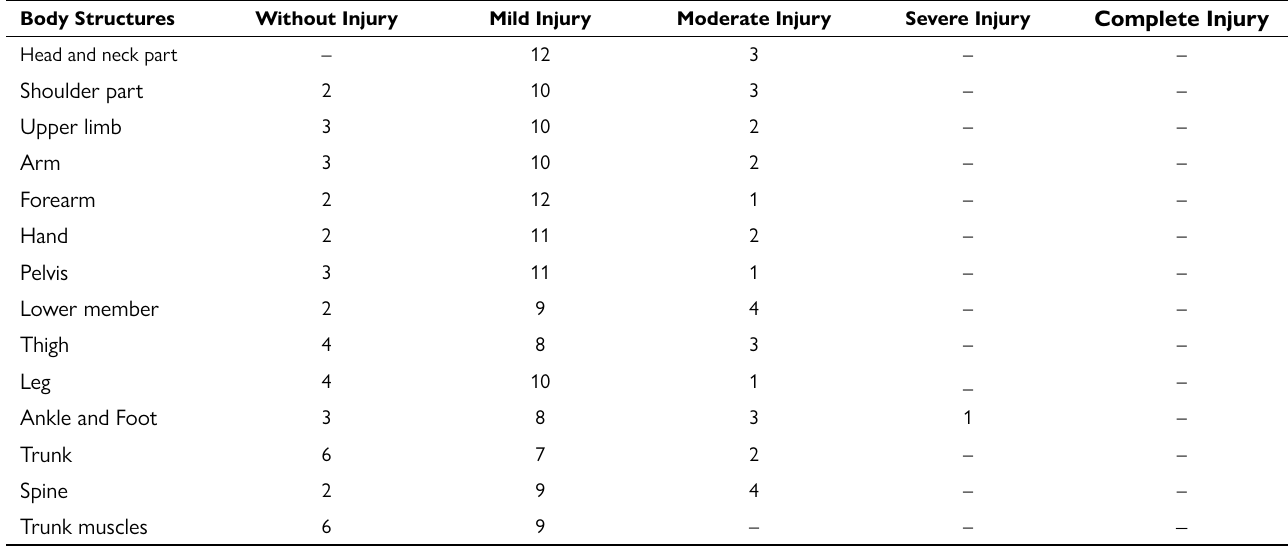
Table 1. Absolute frequency of children and adolescents with MPS in the Body Structures category according to the ICF (n = 15). Body Structures